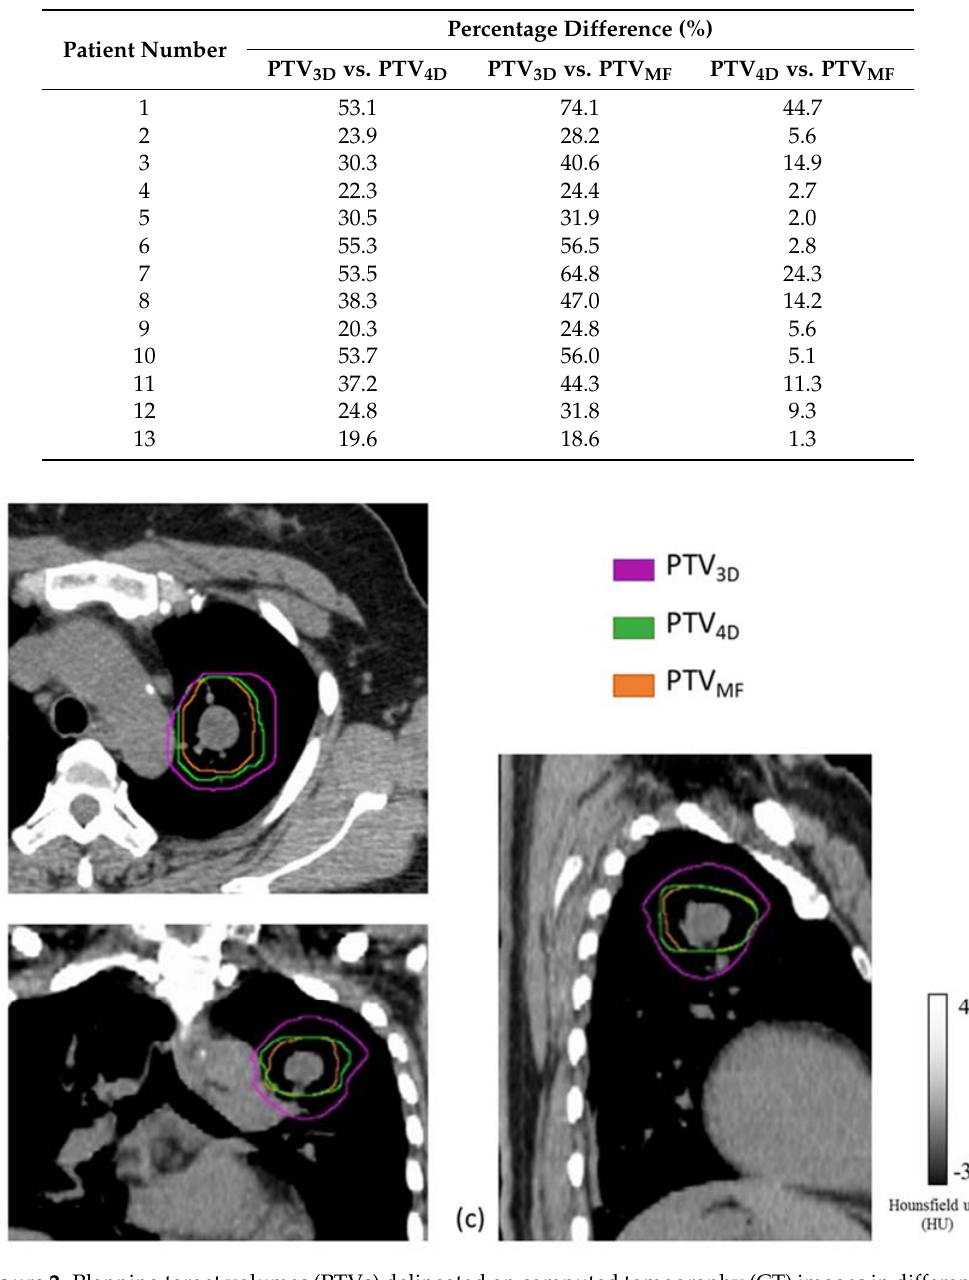
Figure 2. Planning target volumes (PTVs) delineated on computed tomography (CT) images in different treatment plans for respiratory-gated radiation therapy. ( a ) Transverse, ( b ) coronal, and ( c ) sagittal sections of the chest. The purple line represents the PTV3D of the 3D Plan; the green line represents the PTV4D of the 4D Plan; and the orange line represents the PTVMF of the MF-Plan.